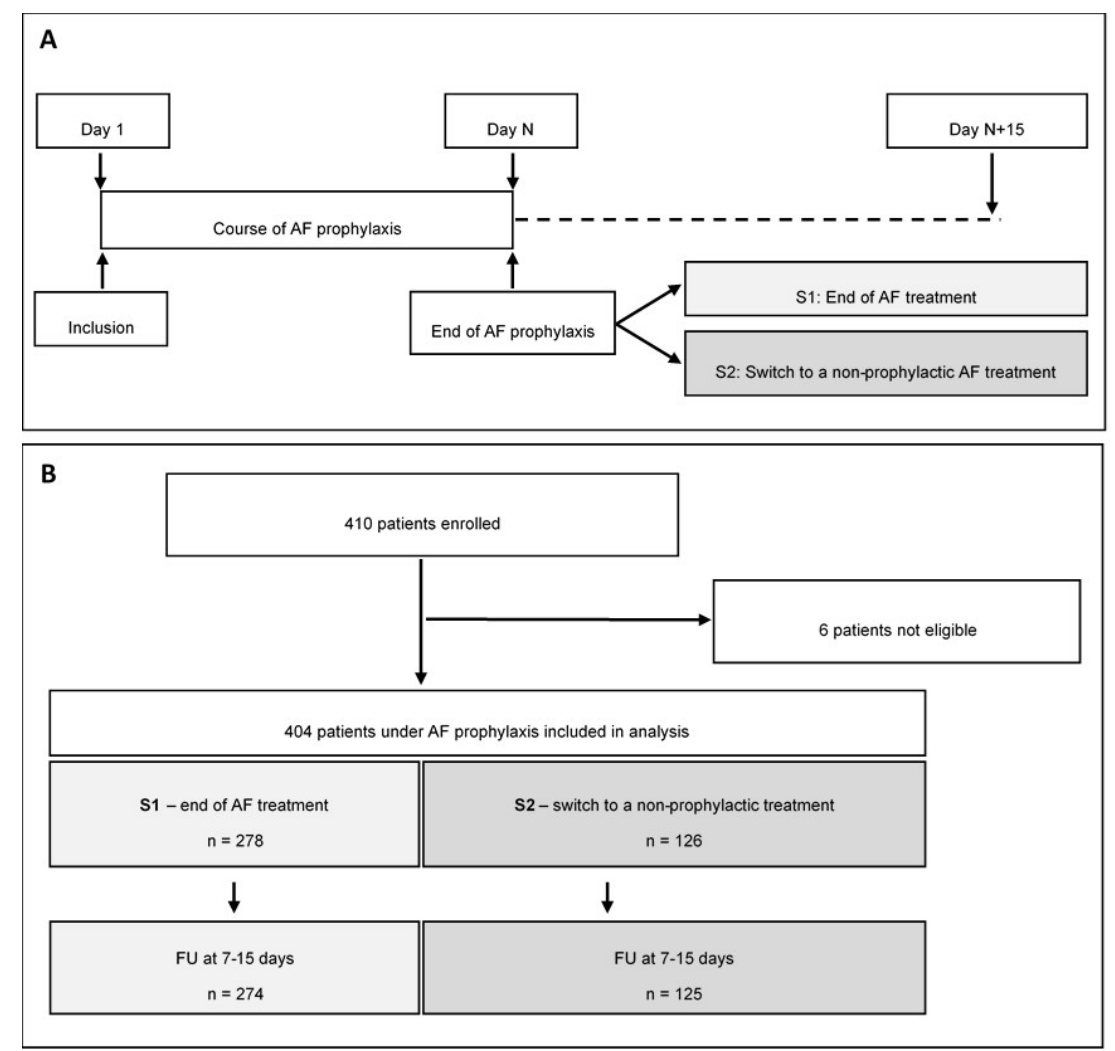
Figure 1. ( A ) Study flow ‐ chart; ( B ) Patient flow ‐ chart.